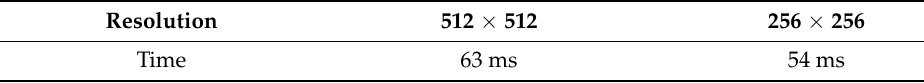
Table 1. The time to process an image of different resolutions.